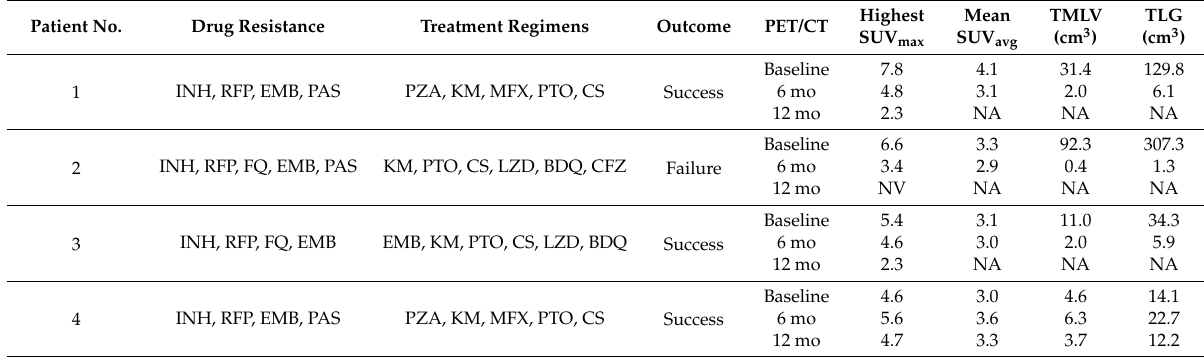
Table 2. Treatment outcomes for MDR-TB and serial changes of positron emission tomography/computed tomography (PET/CT) parameters. Patient